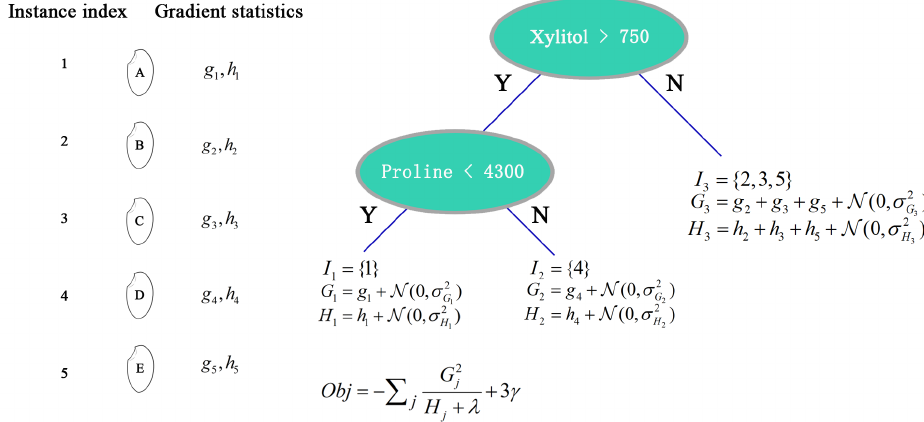
Figure 1. The schematic diagram of DP-XGBoost model. We inject Gaussian noise with σ G and σ H as scale into the first derivative (gradient) and the second derivative (Hessian) respectively to guarantee the ensemble tree model is protected by DP. Gradient and Hessian are applied to calculate the objective function, and the training process aims to minimize the objective